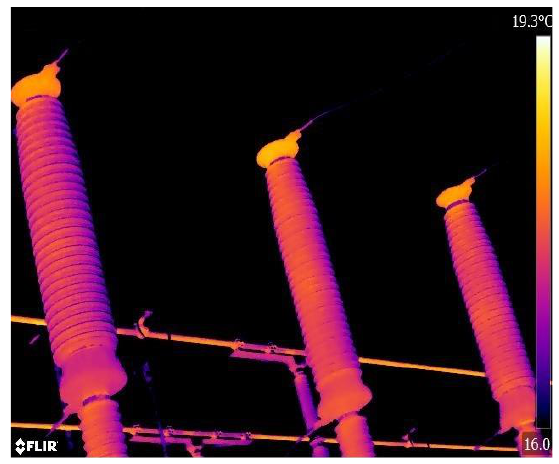
Figure 3. Infrared thermal image of circuit breakers.